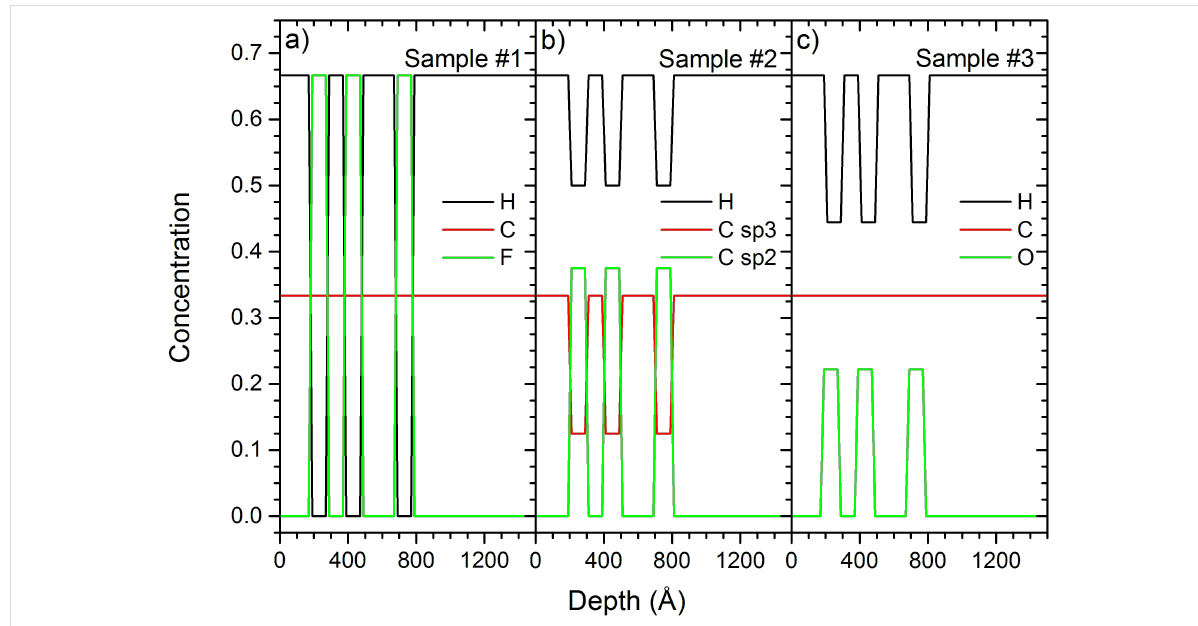
Depth profiling capabilities for He +